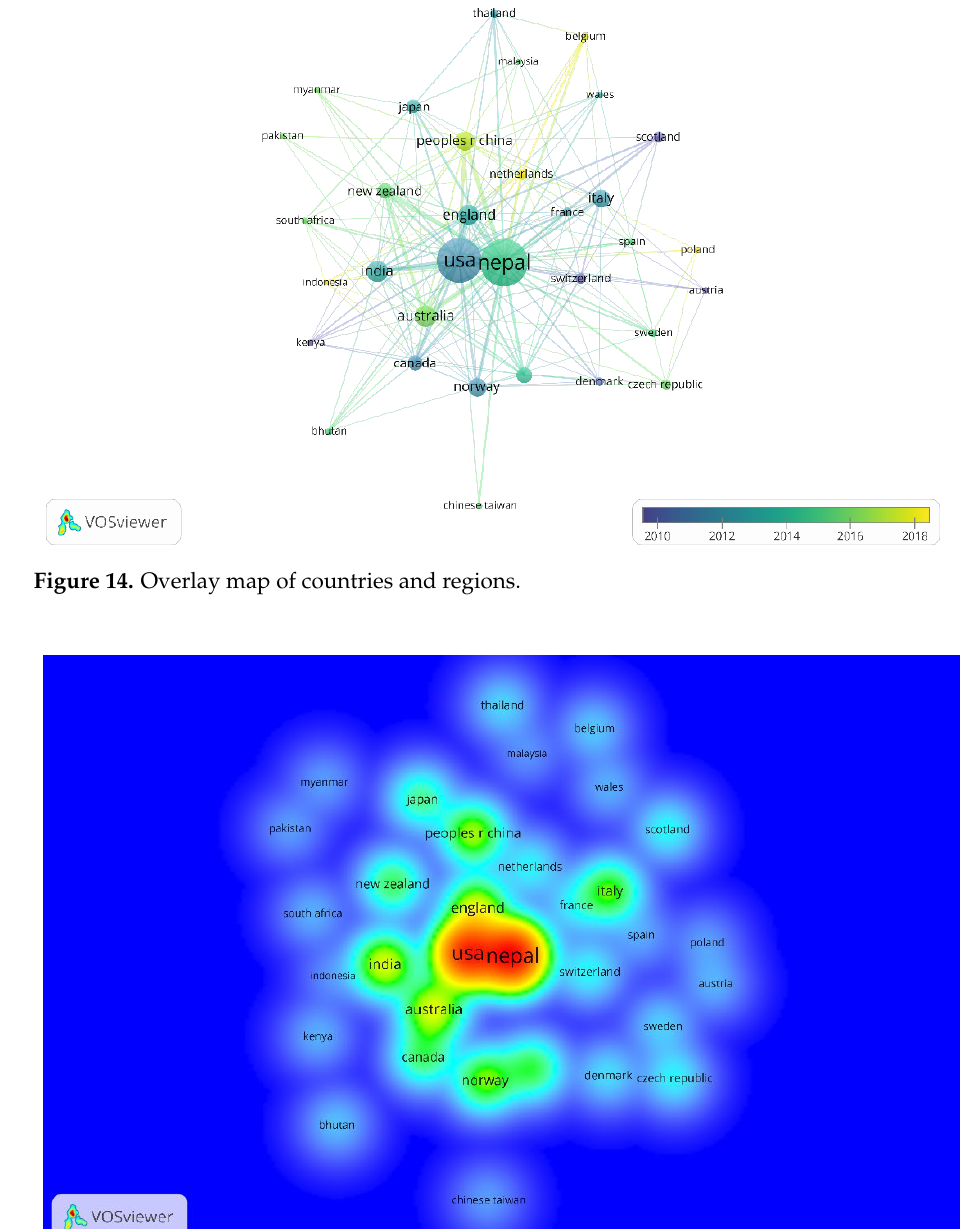
Figure 15. Density map of countries and regions.